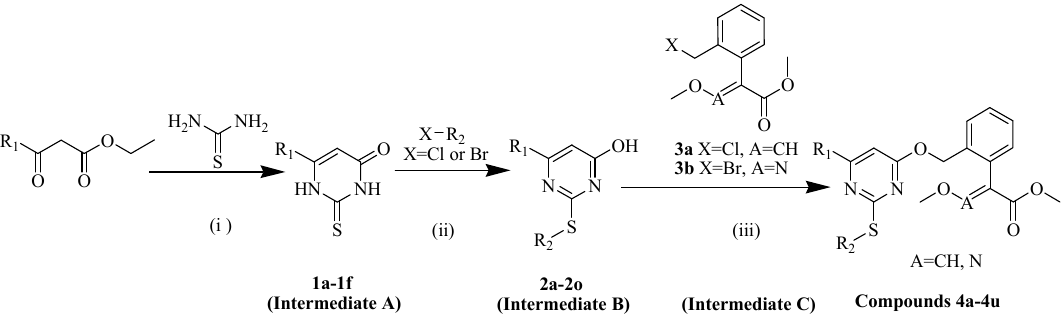
Figure 3. Design strategy of the target compounds.